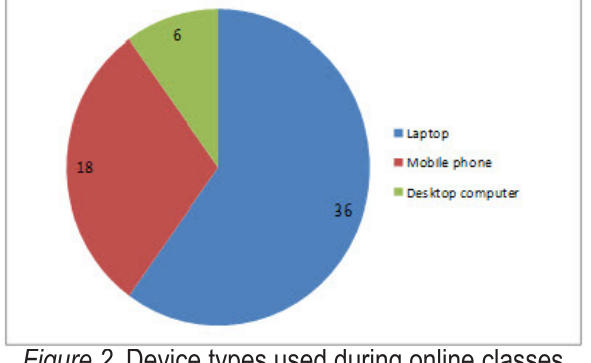
Figure 2. Device types used during online